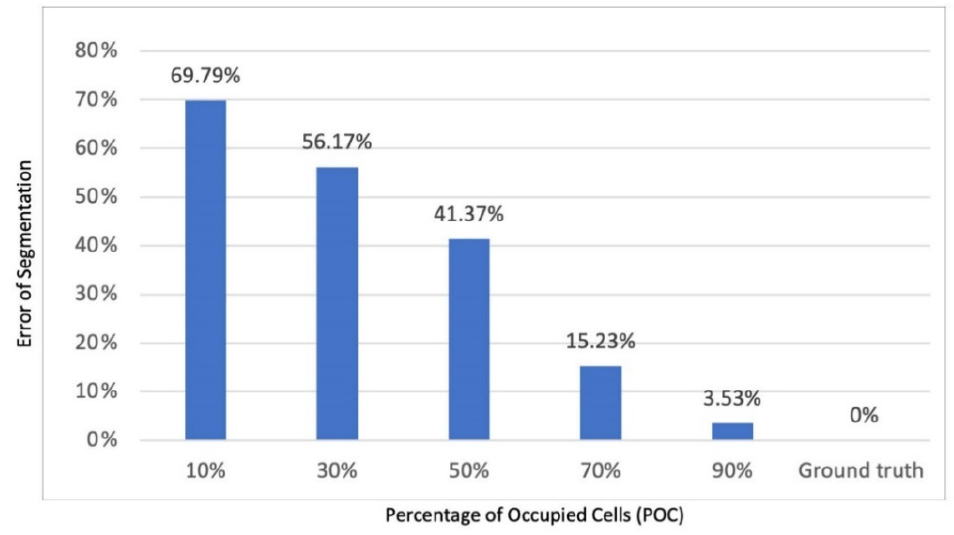
Figure 8. Twenty trials experiments’ section recognized on different MAS.